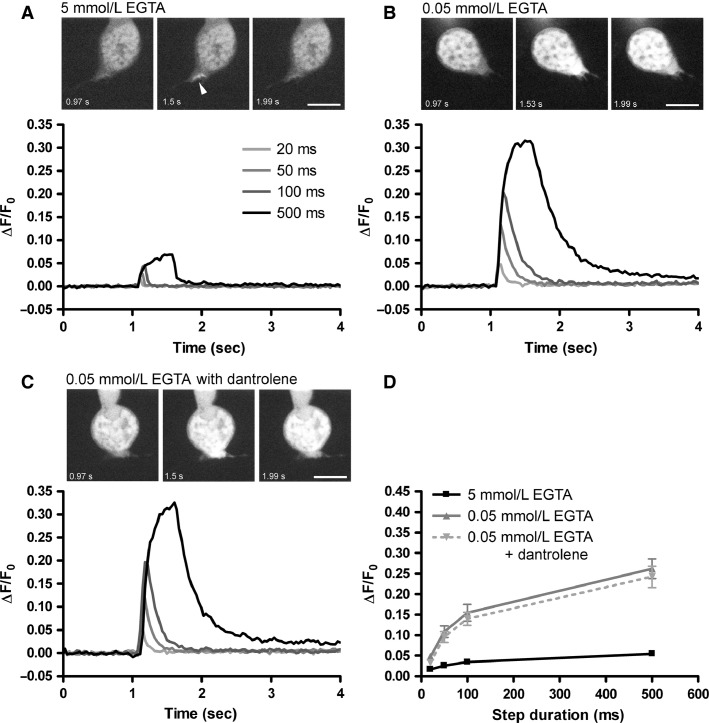
Endogenous levels of Ca2+ buffering enhance intraterminal Ca2+ signals in cones independently of CICR. (A) Ca2+ transients measured in the synaptic terminal of a cone dialyzed with 5 mmol/L EGTA in response to depolarizing voltage steps (to –19 mV from a Vhold = –79 mV) of varying duration (20, 50, 100, and 500 msec). The Ca2+ transients declined rapidly at the end of the voltage step and the peak ΔF/F0 amplitude increased with increasing step duration. The top panel shows OGB-5N fluorescence images acquired before (0.97 sec), at the peak (1.5 sec), and after (1.99 sec) the 500 msec stimulus. The fluorescence signal in this cell was constrained to a cluster of hotspots near the base of the terminal (arrowhead). Scale = 10 μm. (B) In a different cone, the amplitudes of the Ca2+ signals were enhanced and recovery slowed with 0.05 mmol/L intracellular EGTA. The top panel shows the OGB-5N fluorescence images, demonstrating that with 0.05 mmol/L EGTA, the OGB-5N fluorescence was stronger and spreads throughout the terminal. Scale = 10 μm. (C) As shown in a different cone, this enhancement with 0.05 mmol/L EGTA was not affected by including 50 μmol/L dantrolene in the patch pipette. The top panel shows the OGB-5N fluorescence images. Scale = 10 μm. (D) Group data showing the increase in ΔF/F0 with increasing step duration, the enhancement with 0.05 mmol/L EGTA, and the lack of an effect of dantrolene on the enhanced Ca2+ signal.